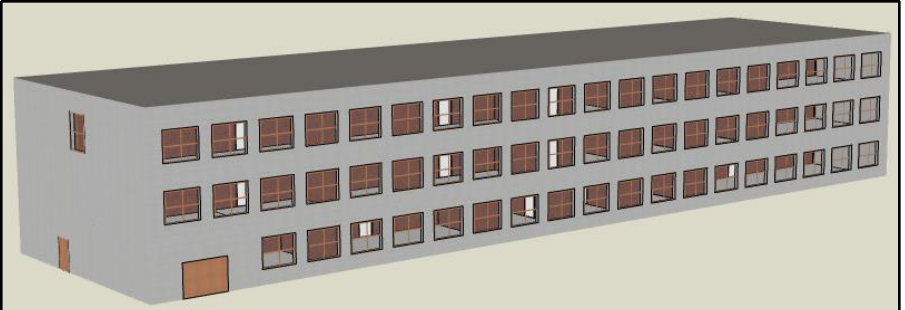
Figure 7. Visualisation of the “D” building (extract from “DesignBuilder”).